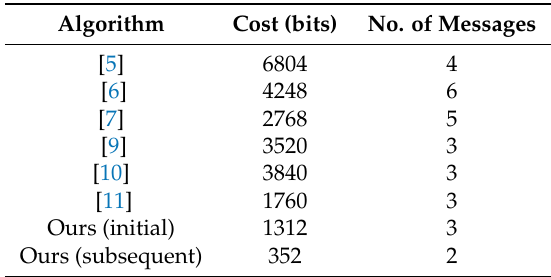
Table 2. Comparison of communication costs.